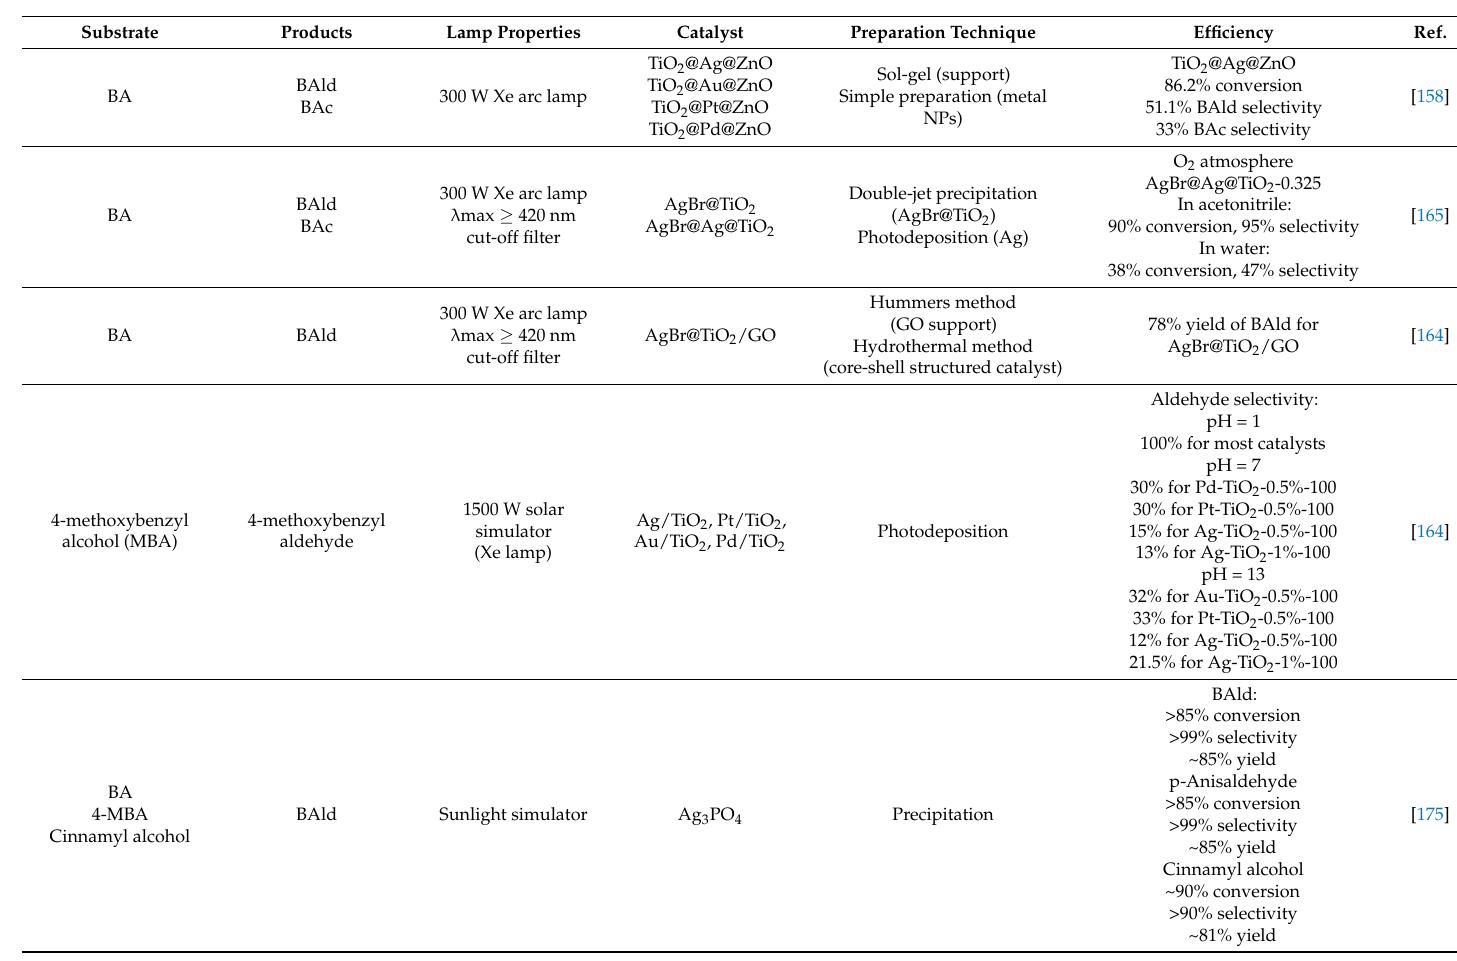
Table 7. A selection of Ag-containing photocatalysts for alcohol